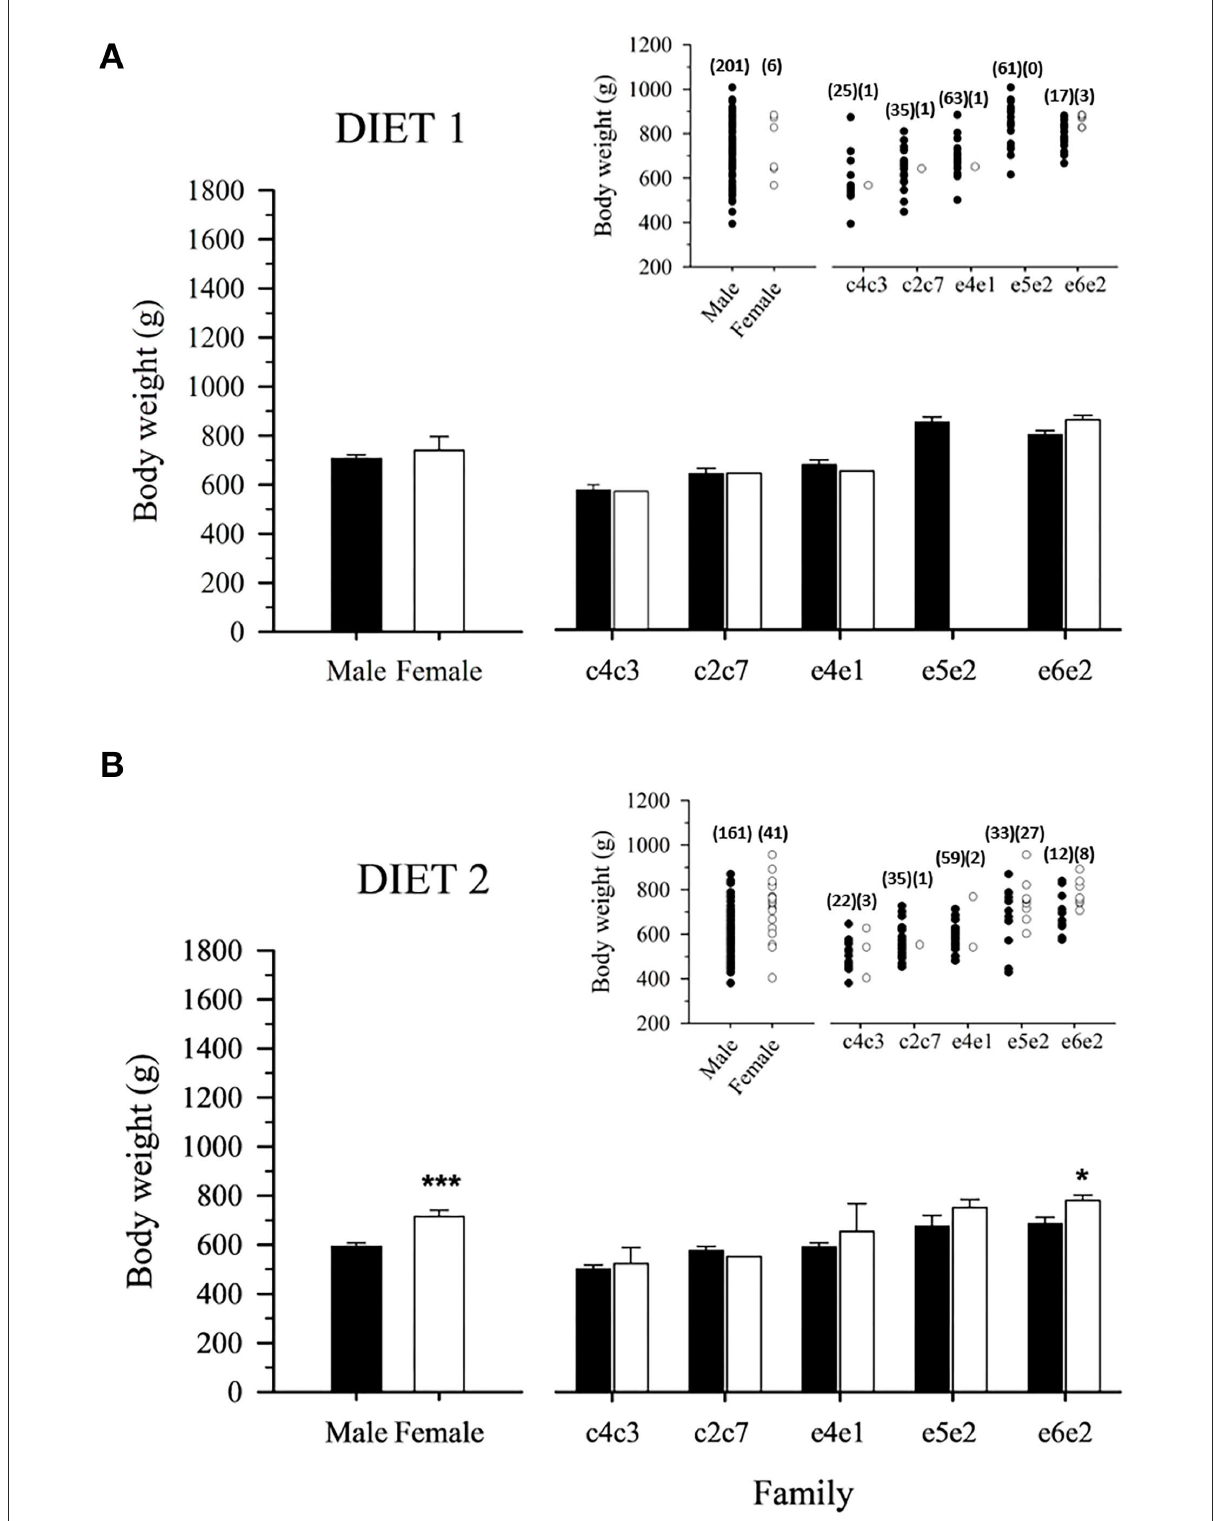
FIGURE2 Mean male and female body weight of 2-year-old gilthead sea bream-fed control (A) or experimental diet (B) as a whole population and separated by family. Values are the mean ± SEM of three tanks per diet ( n = 207 fish for diet 1, 202 for diet 2). Asterisks indicate significant differences (Student’s t -test, P < 0.05) between males and females body weight. Inserts indicate individual body weight in each population. The number of males and females for the populations and families is indicated in